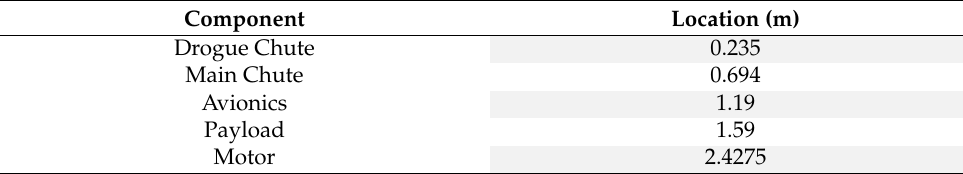
Table 8. Component centroid location relative to the nose cone.